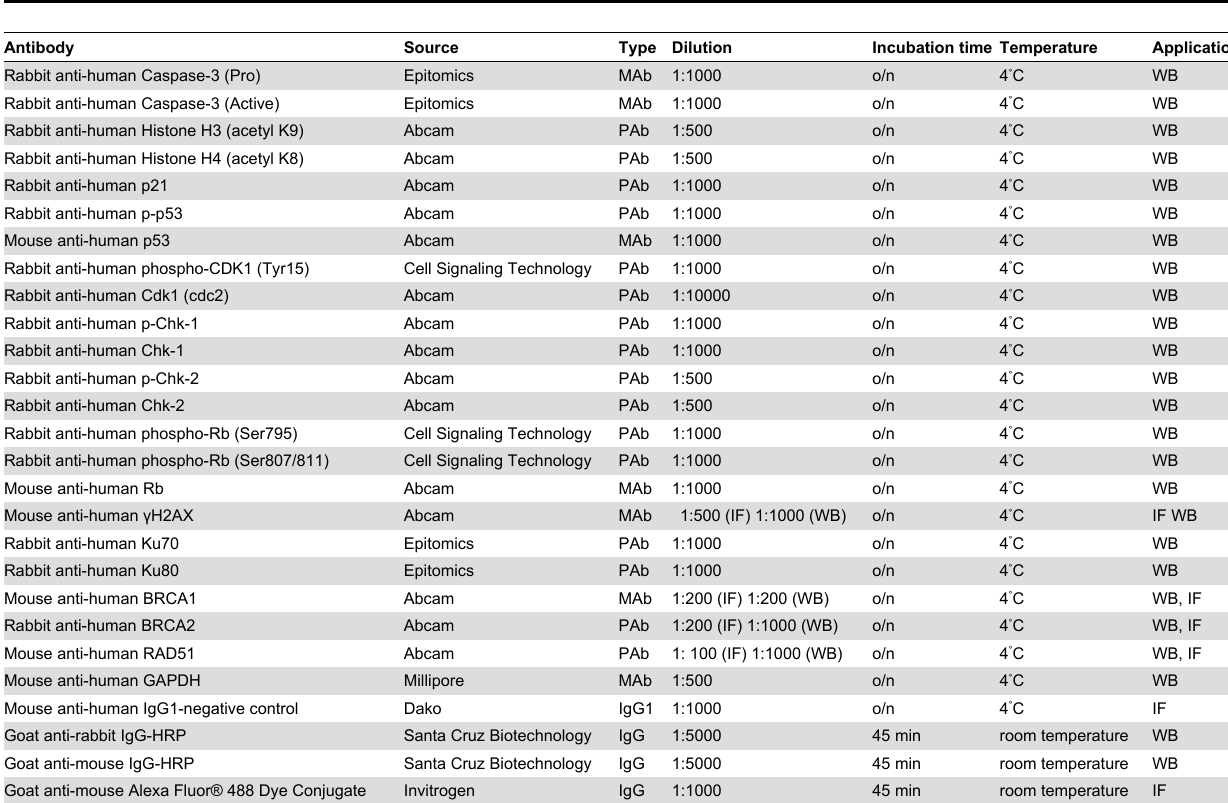
Table 1. Antibodies used for western blotting and immunofluorescence staining.